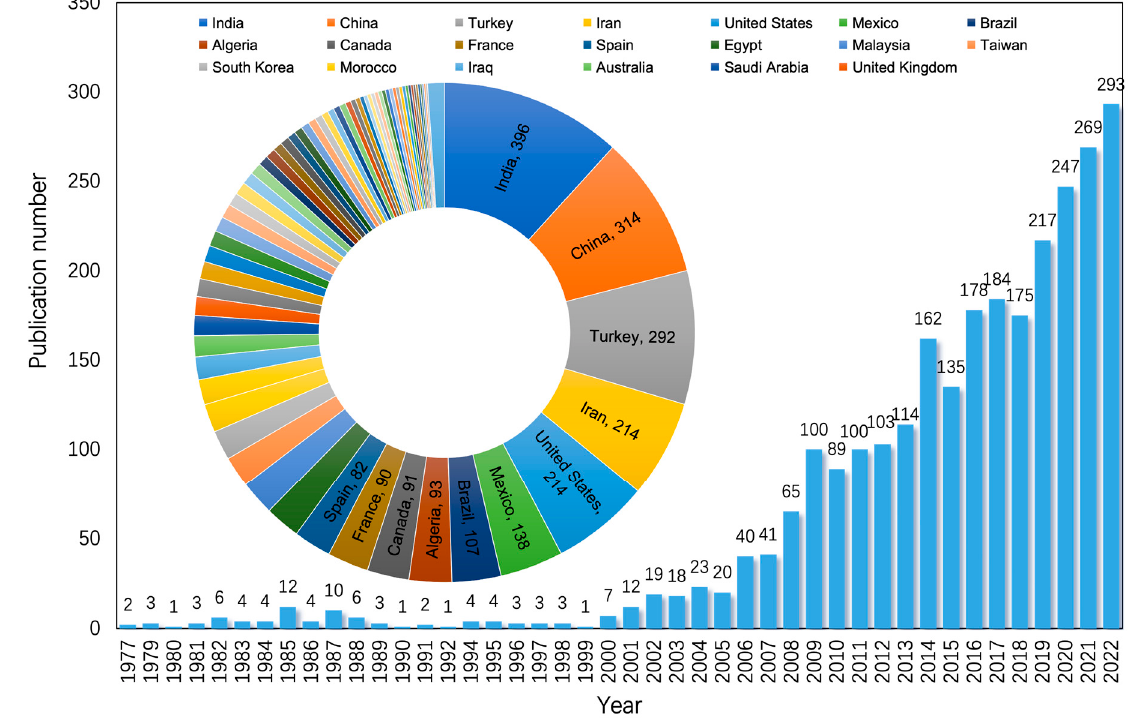
Figure 3. The number of publications per year and each of the productive countries in EC study.